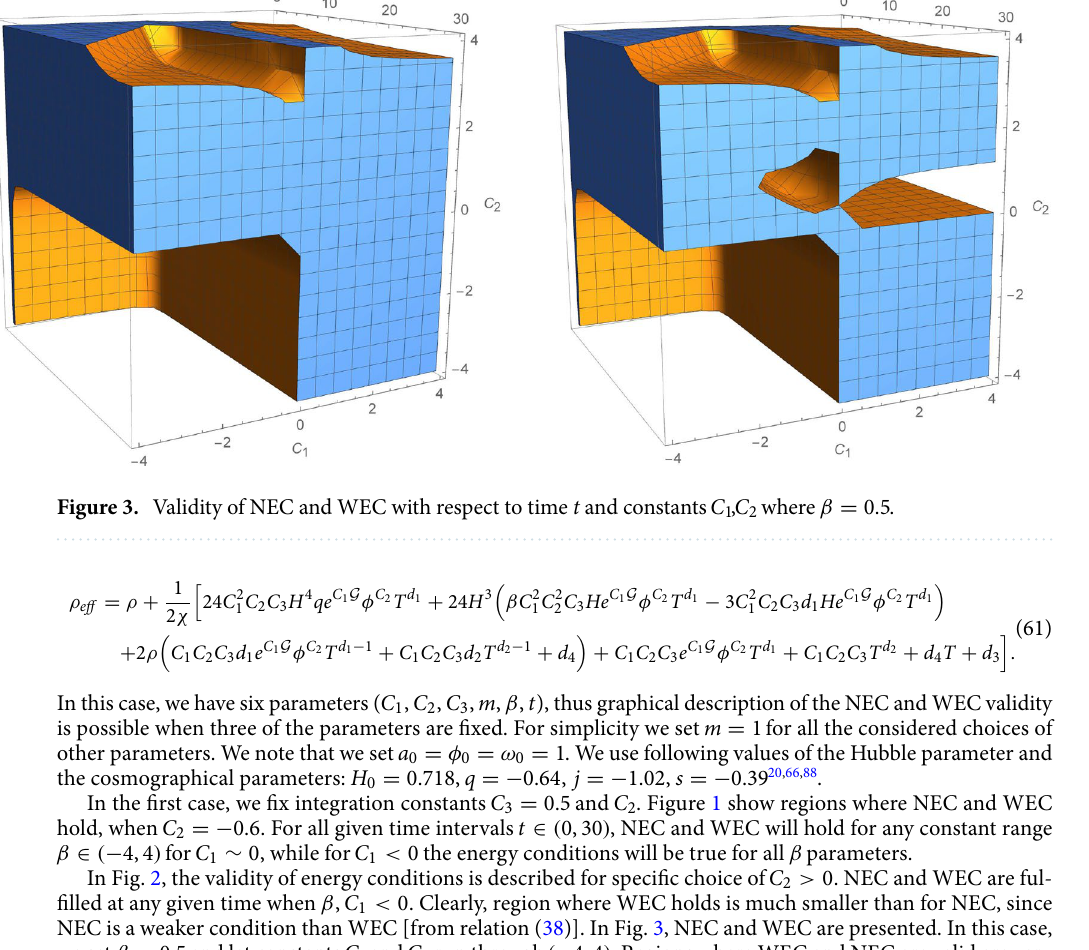
Figure 3. Validity of NEC and WEC with respect to time t and constants C 1 , C 2 where β